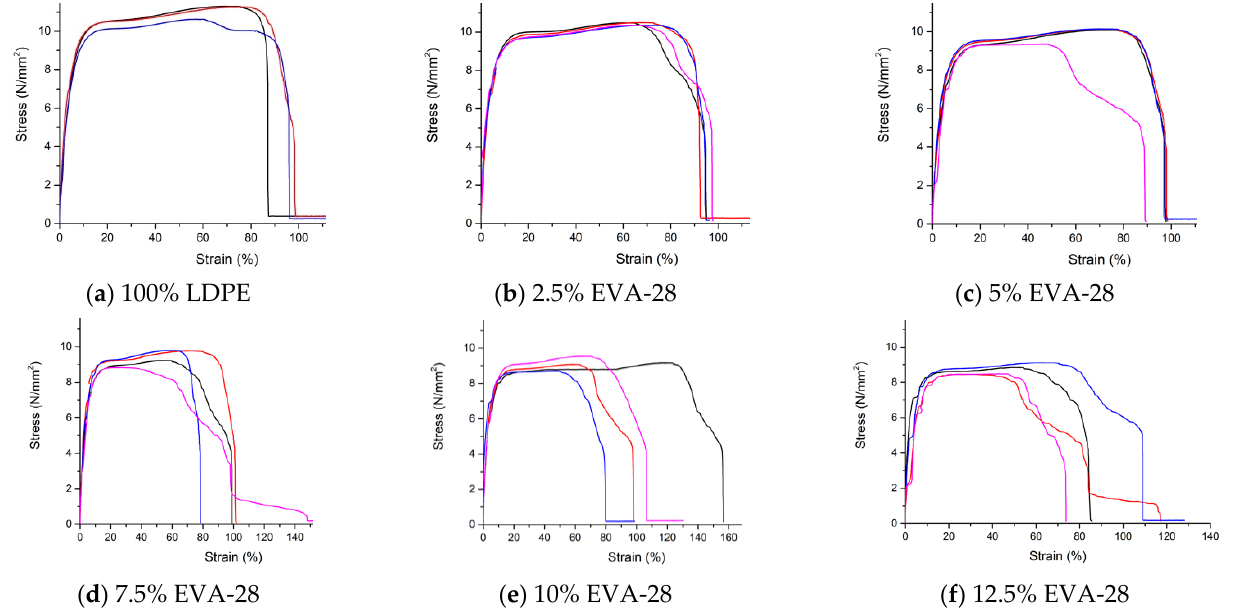
Figure 2. Stress–strain curves of tensile strength of LDPE/EVA samples. Table 2. Average results of tensile strength (MPa).